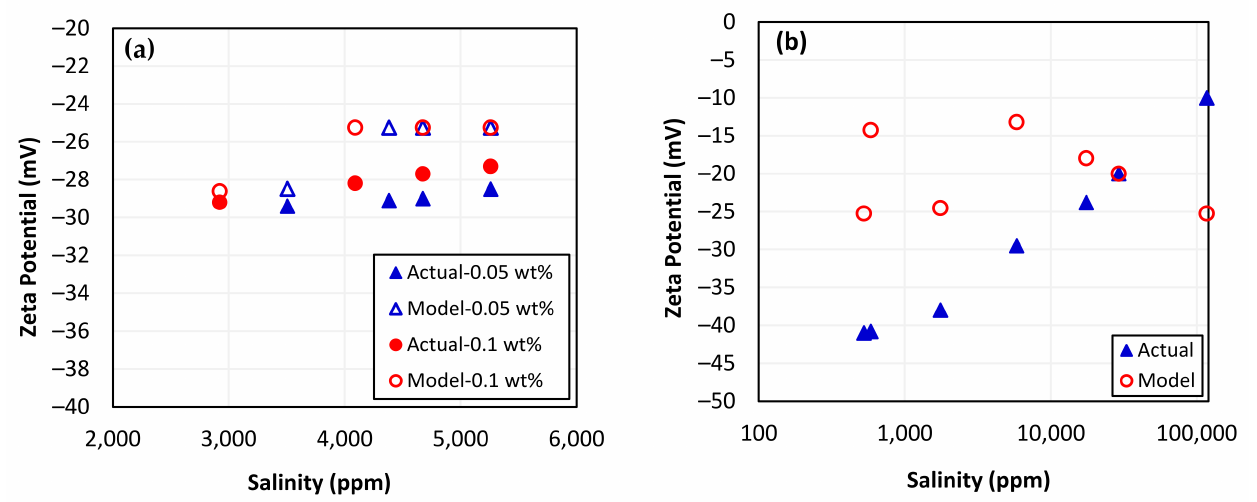
Figure 4. Zeta potential predictions using SVM model: ( a ) sand with nanoparticles and ( b ) only sand.